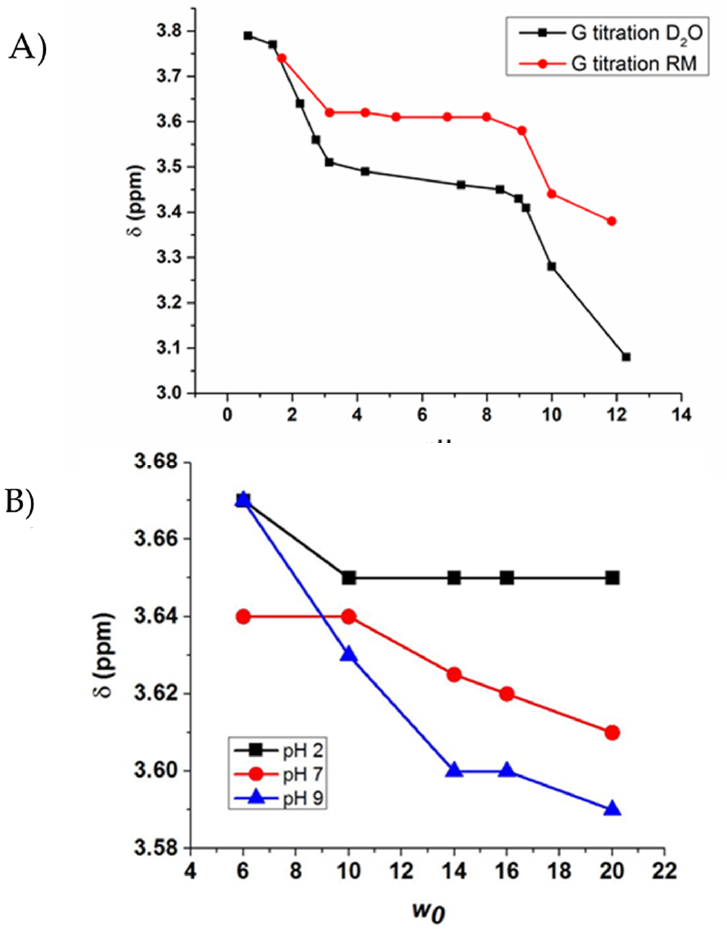
Figure 2. ( A ) Comparison of 1 H NMR chemical shifts of G in aqueous and RM environments. ( B ) The 1 H NMR chemical shift of G is plotted with increasing w 0 at pH 2, 7, and 9. Error bars have been included in the plot; however, due to minimal error, they are not visible beyond the symbols used in the graph.